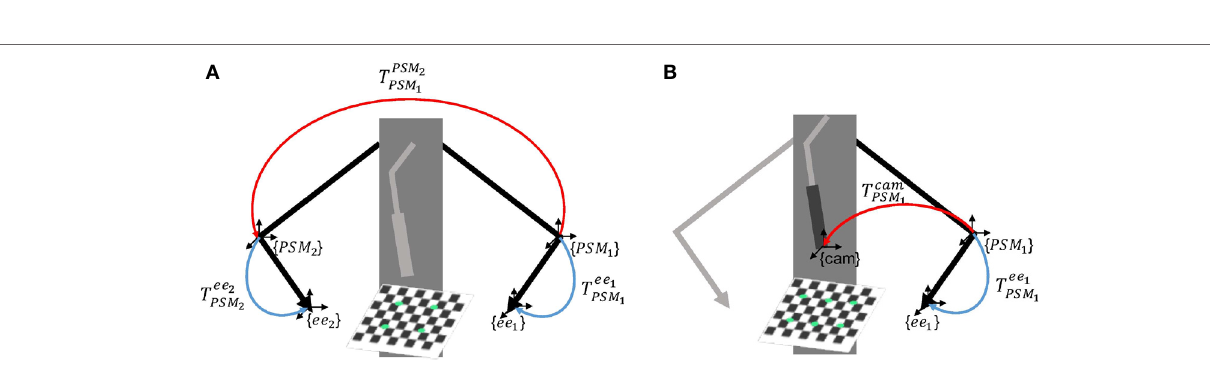
FigUre 3 | scheme of the calibrations involved in enVisors . Panel (a) shows the Arm to Arm Calibration between {PSM1} and {PSM2} and panel (B) shows the Arm to Camera calibration between {PSM1} and {cam}; the unknown transformations are reported in red, while the known robotic arm poses in blue.